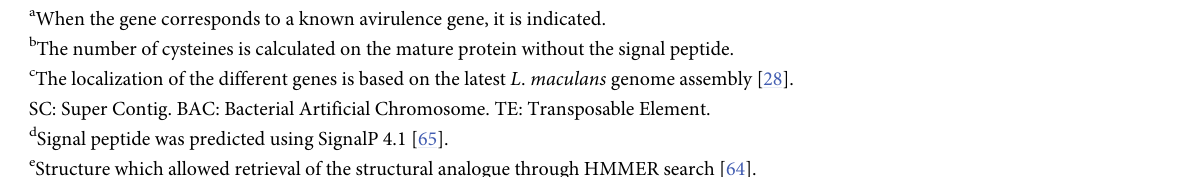
a When the gene corresponds to a known avirulence gene, it is indicated. b The number of cysteines is calculated on the mature protein without the signal peptide. c The localization of the different genes is based on the latest L . maculans genome assembly [28]. SC: Super Contig. BAC: Bacterial Artificial Chromosome. TE: Transposable Element. d Signal peptide was predicted using SignalP 4.1 [65]. e Structure which allowed retrieval of the structural analogue through HMMER search [64].